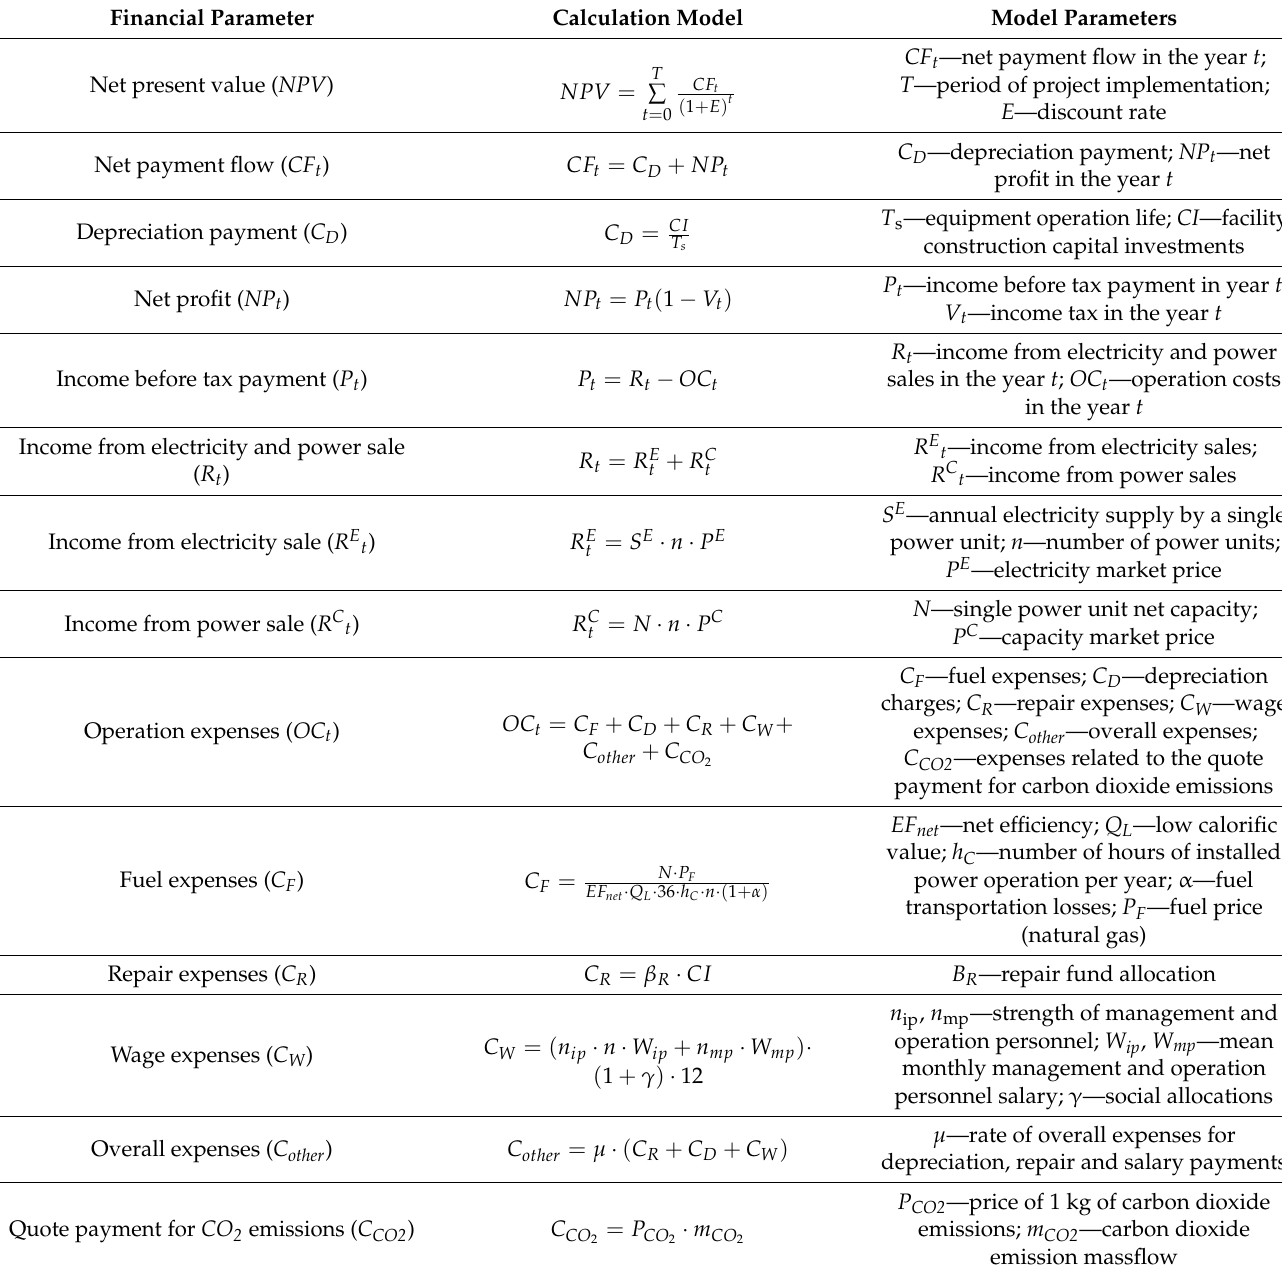
Table 5 and Figure 13 demonstrate the analysis method for the comparative financial efficiency of power plant construction in terms of the discounted income, including carbon dioxide emission quotes payment. Table 5. Analysis method for the comparative financial efficiency of power plant construction, including carbon dioxide emission quotes